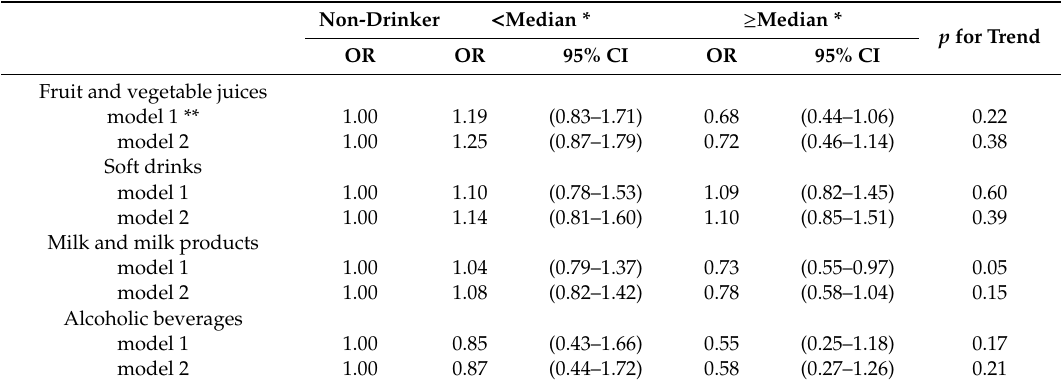
Table 5. Multivariate adjusted odds ratios and 95% CI for obesity according to consumption